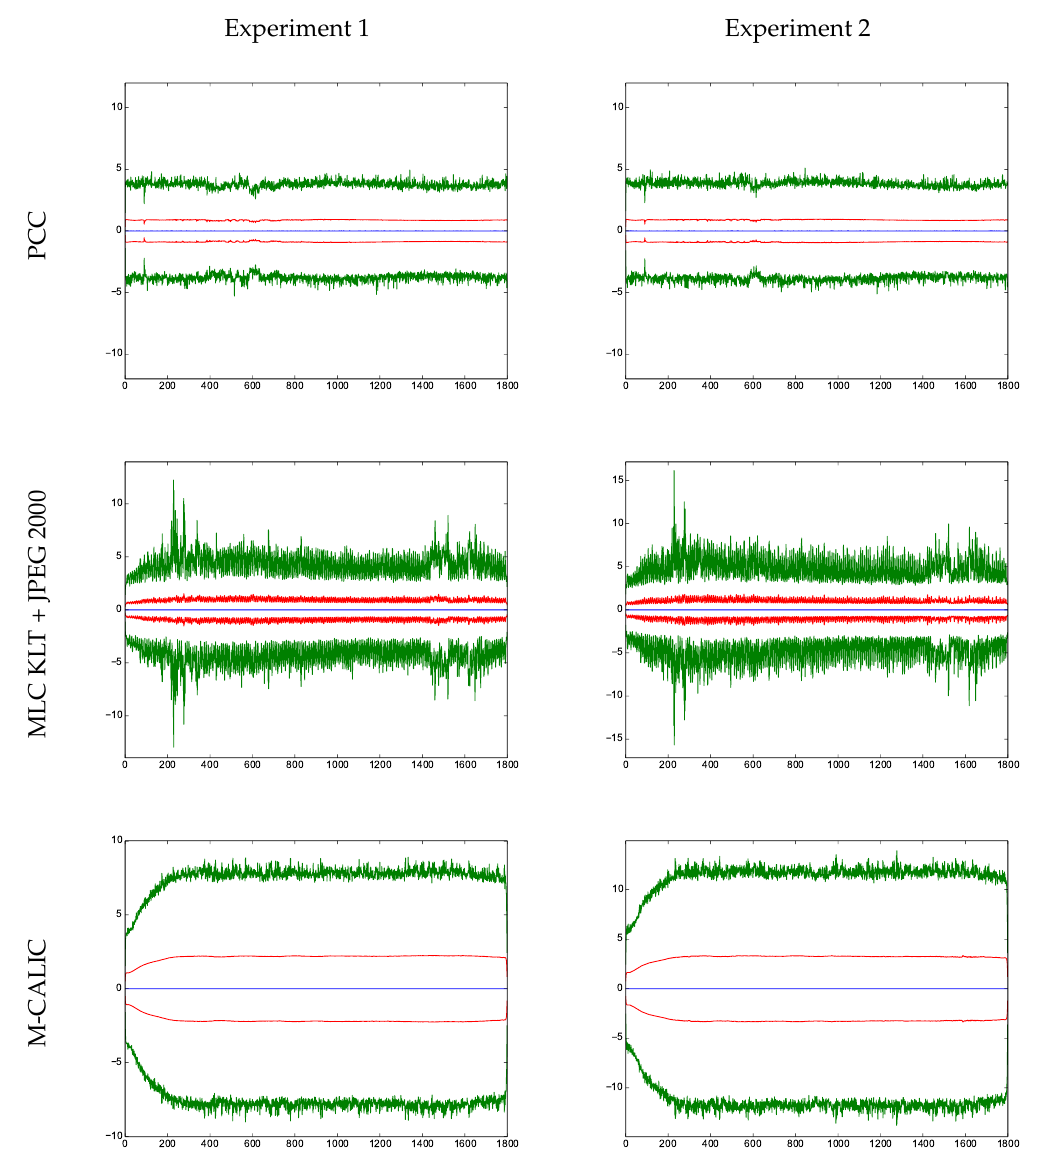
Figure 15. Normalized radiance residuals statistics. The average of the normalized radiance residuals is shown in blue, standard deviation in red, and maximum and minimum values in